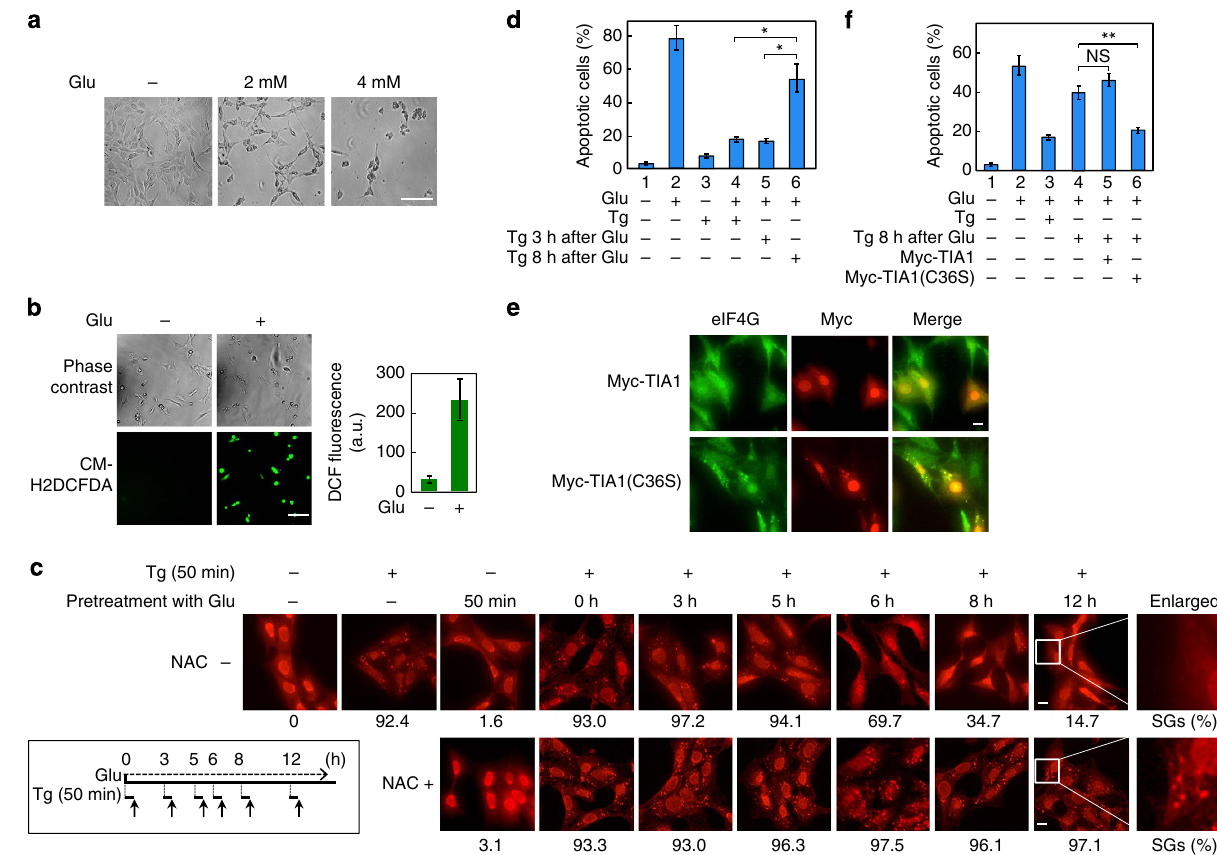
Figure 3 | TIA1(C36S) expression restores SG formation under oxidative stress conditions and suppresses apoptosis in HT22 cells. ( a ) HT22 cells were treated with the indicated concentrations of Glu for 24h. Cell morphology was examined by phase contrast microscopy. ( b ) HT22 cells were incubated with 4mM Glu for 6h. ROS production was visualized by fluorescence microscopy using the ROS probe, CM-H 2 DCFDA (lower panels). The 2 0 ,7 0 - dichlorodihydrofluorescein (DCF) fluorescence intensity (a.u.) was measured for 4 200 cells and is shown in the graph (right). Error bars indicate s.e.m. ( n ¼ 3). ( c ) HT22 cells were treated with 0.2 m M Tg and 4mM Glu as indicated. Tg was added either 3, 5, 6, 8 or 12h after Glu treatment, and SGs were visualized after another 50-min incubation by fluorescence analysis of endogenous G3BP (upper panels). NAC (5mM) was added to the medium 20min before Glu treatment (lower panels). ( d ) HT22 cells were treated with 0.2 m M Tg and 4mM Glu as indicated. Twenty hours after Glu treatment, apoptosis was assayed by staining with Annexin V-Cy3 and visualized by fluorescence microscopy. Error bars indicate s.e.m. ( n ¼ 3). * P o 0.02, Student’s t -test. ( e ) HT22 cells were transfected with either Myc-TIA1 or Myc-TIA1(C36S) and were incubated for 36h. Cells were then treated with 4mM Glu and, after 8h incubation, were treated with 0.2 m M Tg for another 50min. SGs and Myc-tagged TIA1 were analysed by immunofluorescence microscopy using anti-eIF4G and anti-Myc antibodies, respectively. ( f ) HT22 cells, HT22-Myc-TIA1 or HT22-Myc-TIA1(C36S) stable cell lines were treated with 4mM Glu and 0.2 m M Tg as indicated. Twenty hours after Glu treatment, apoptosis was measured as in d . Error bars indicate s.e.m. ( n ¼ 3). ** P o 0.01, Student’s t -test. Scale bars, 100 m m ( a , b ) or 10 m m ( c , e